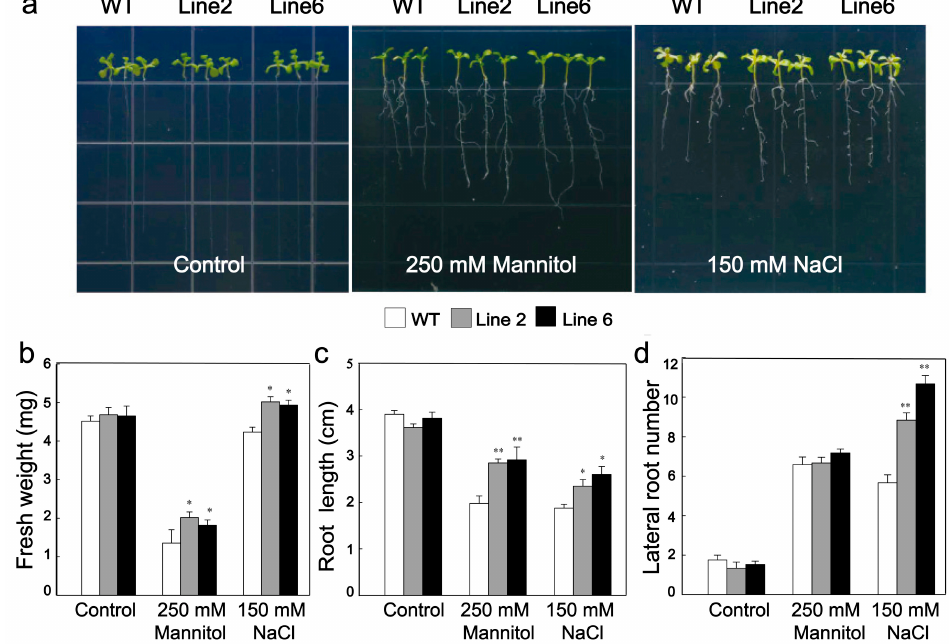
Figure 4. Growth of WT plants and two ScDREB10 transgenic Arabidopsis lines under osmotic and salt stresses at seeding stage. One-week-old seedlings of WT and transgenic Arabidopsis cultured on Murashige and Skoog (MS) medium were transferred on the MS agar plates (control), MS agar plates supplied with 250 mM mannitol (osmotic stress) or 150 mM NaCl (salt stress), and maintained for 7 days. ( a ) Growth of WT and transgenic Arabidopsis plant on MS medium (control) and MS medium supplied with 250 mM mannitol and 150 mM NaCl for 7 days. ( b ) Comparison of fresh weight between WT and transgenic plants. ( c ) Comparison of root length between WT and transgenic plants. ( d ) Comparison of lateral root number between WT and transgenic plants. More than 20 plants of WT and each transgenic seedling lines were used in this experiment for further calculating the fresh weight, length root, and lateral root number. Values are means ± SE of at least twenty plants). Asterisks indicate statistically significant differences from WT (* P < 0.05, ** P < 0.01).